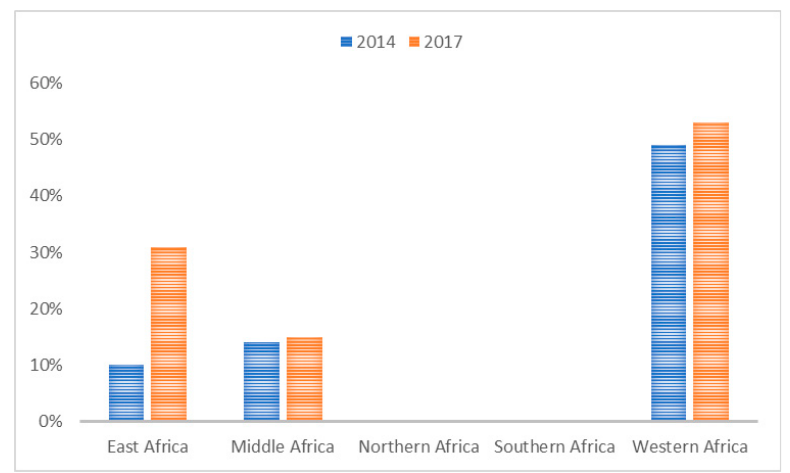
Figure 3. The population of people in Africa covered by legislation on e-waste disposal. Source: [25,29].